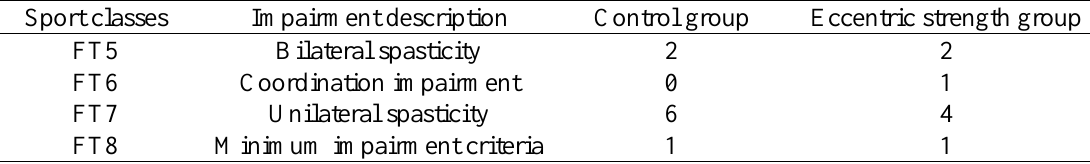
Table 2. Sport classes and description of physical impairments of the participants Sport